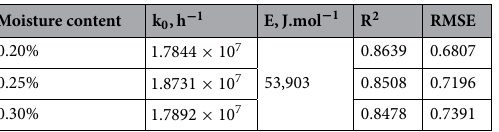
Table 7. Arrhenius constants and activation energy based on rate constant dependency on temperature.